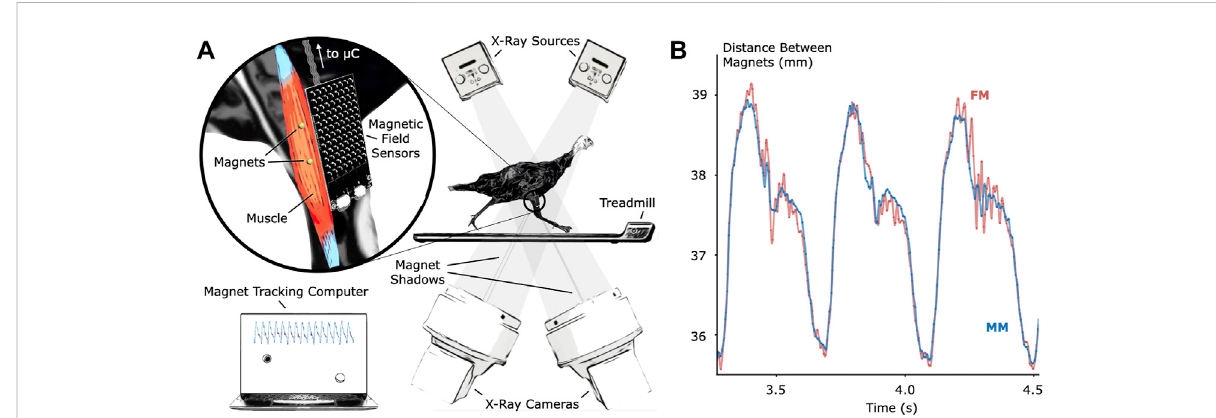
FIGURE 1 Validation of Untethered Muscle Tracking using Magnetomicrometry. (A) A magnetic fi eld sensing array on the surface of the leg tracks the positions of two magnetic beads implanted into the muscle. A feather microcontroller ( μ C) in the turkey feathers wirelessly transmits the magnetic fi elddatatoamagnettrackingcomputerthatcalculatesanddisplaysthemagnetomicrometry(MM)signalinrealtime.Theturkeyswalkedandranon a treadmill while x-ray video cameras recorded synchronized fl uoromicrometry (FM) data for post-processing. (B) Comparison of MM (blue) with FM (red) to validate the MM accuracy. These representative results during running gait show the submillimeter accuracy of MM during untethered muscle length tracking.